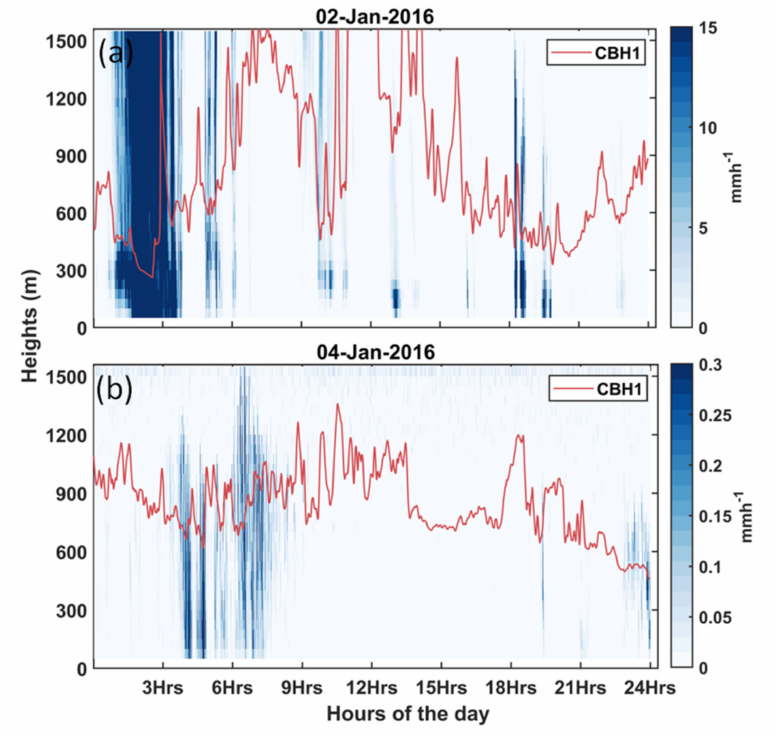
Figure 10. Relationships between CBH1 vs. precipitation intensity for ( a ) heavy rainy day and ( b ) light rainy